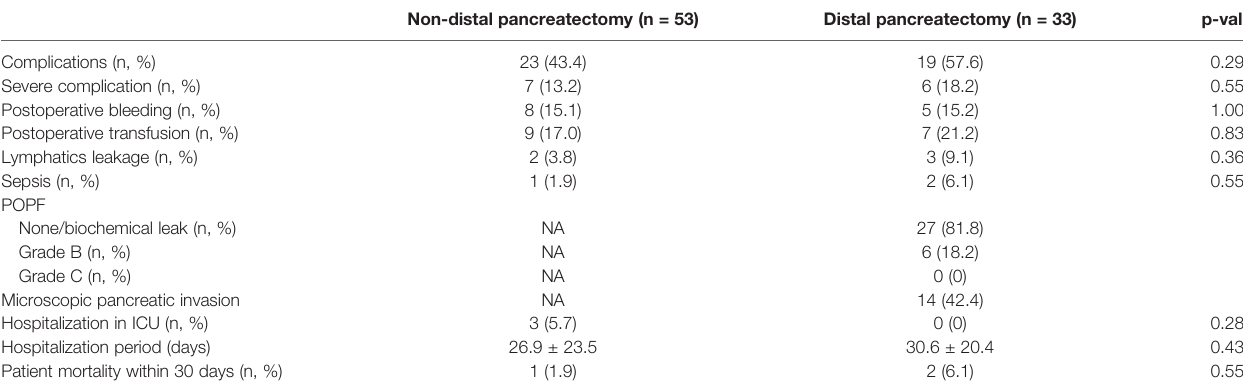
TABLE 2 | Clinical outcomes according to resection of the pancreas.